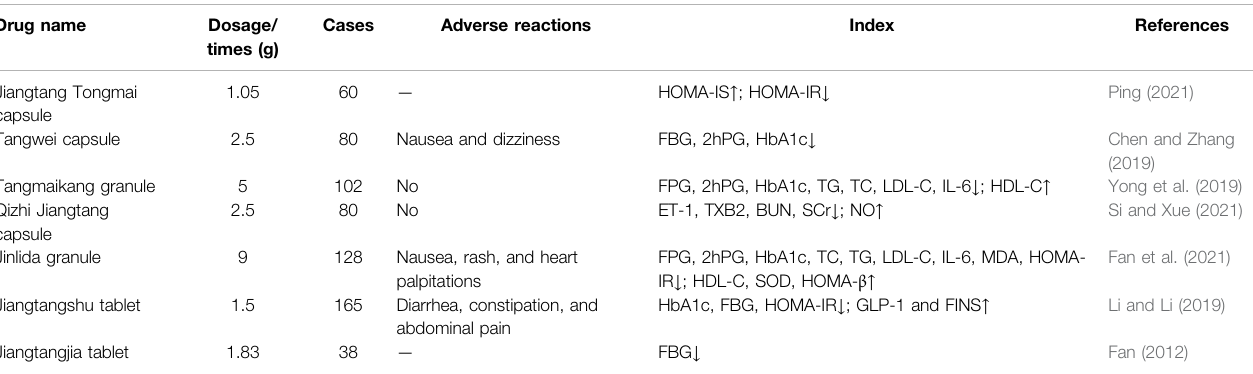
TABLE 4 | Chinese patent medicines containing Polygonatum with hypoglycemic effect in human